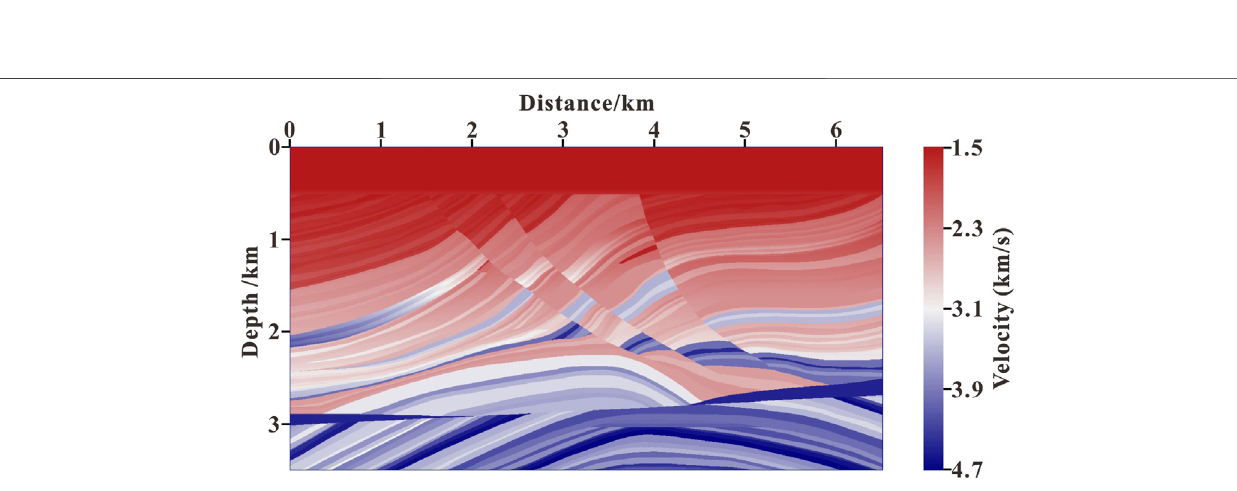
FIGURE 7 | The local velocity model of the Marmousi-II